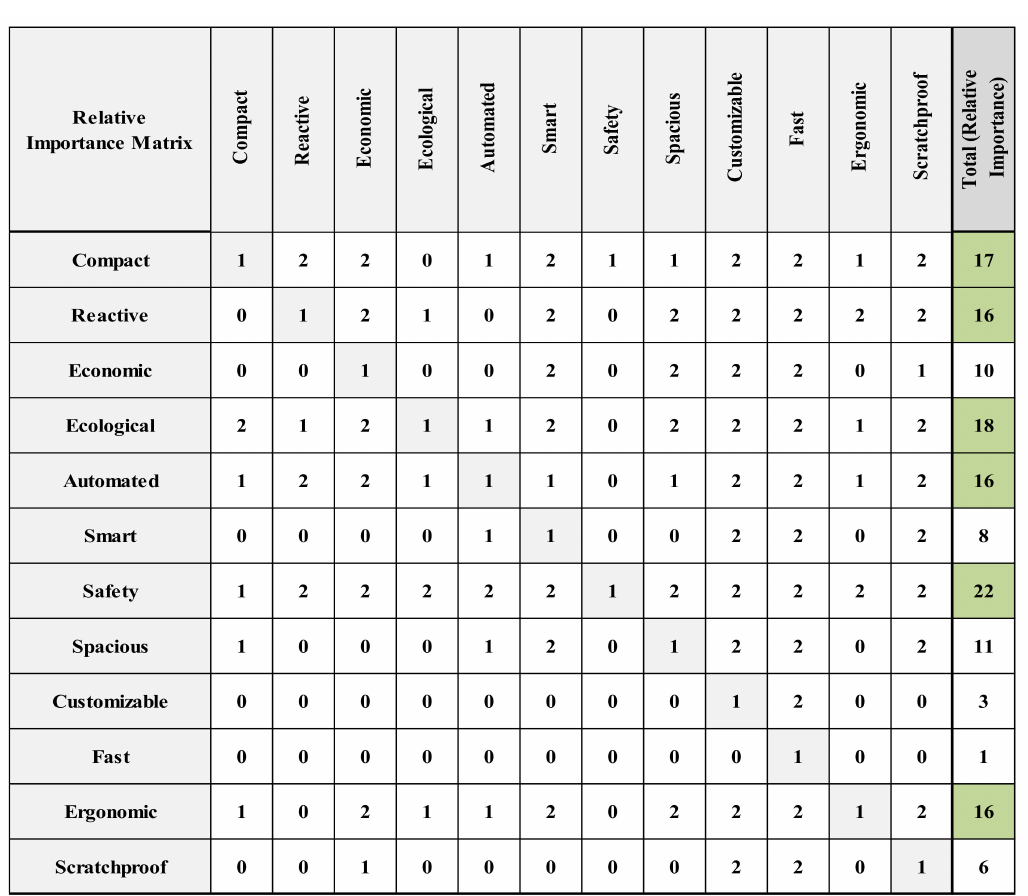
Figure 8. Relative Importance